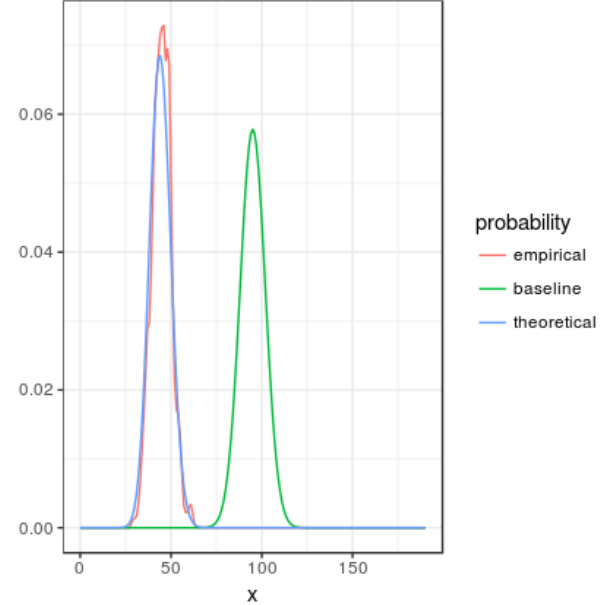
Figure 1. Comparison among smoothed probability mass functions: baseline, theoretical and empirical for p a = 0.3 and p r =